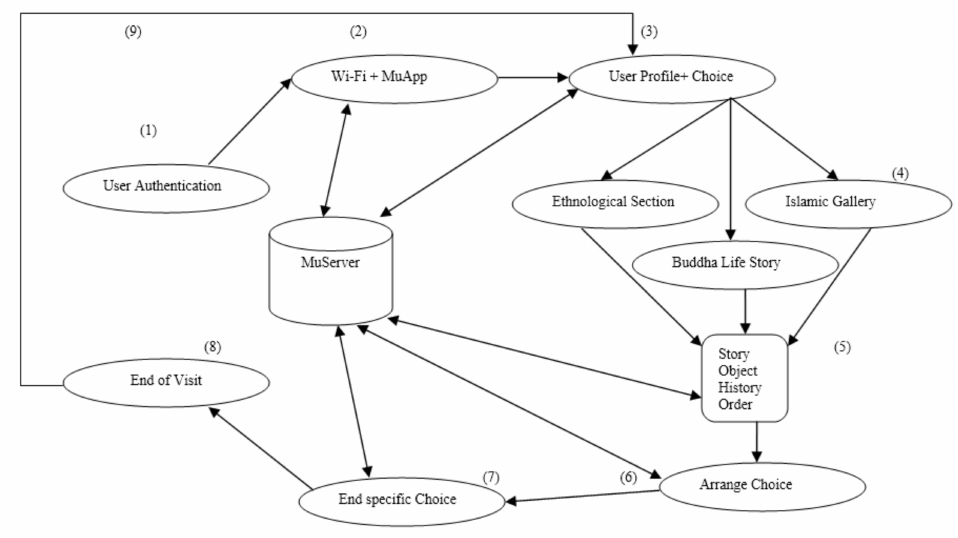
Figure 7. System level view of